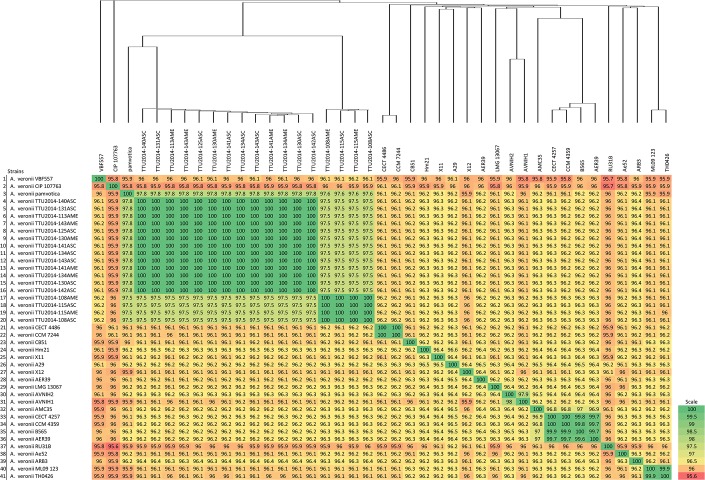
Average nucleotide identity (ANI) values of A. veronii genomes and phylogenetic tree analysis based on the core genomes.Note that branch lengths of the phylogenetic tree were reduced to fit the image.